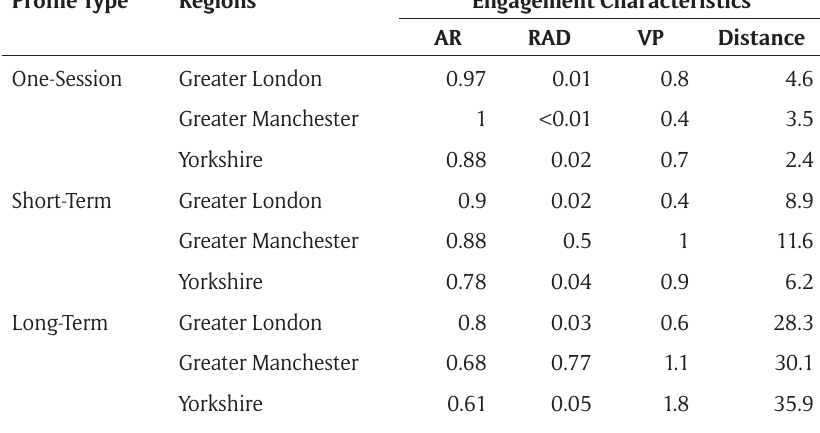
Table 5: Mean centroids for each of the engagement characteristics (Activity Ratio [AR], Relative Activity Duration [RAD], Variation in Periodicity [VP] and Distance Travelled in miles [Distance]) compared across each region and sub- divided by profile